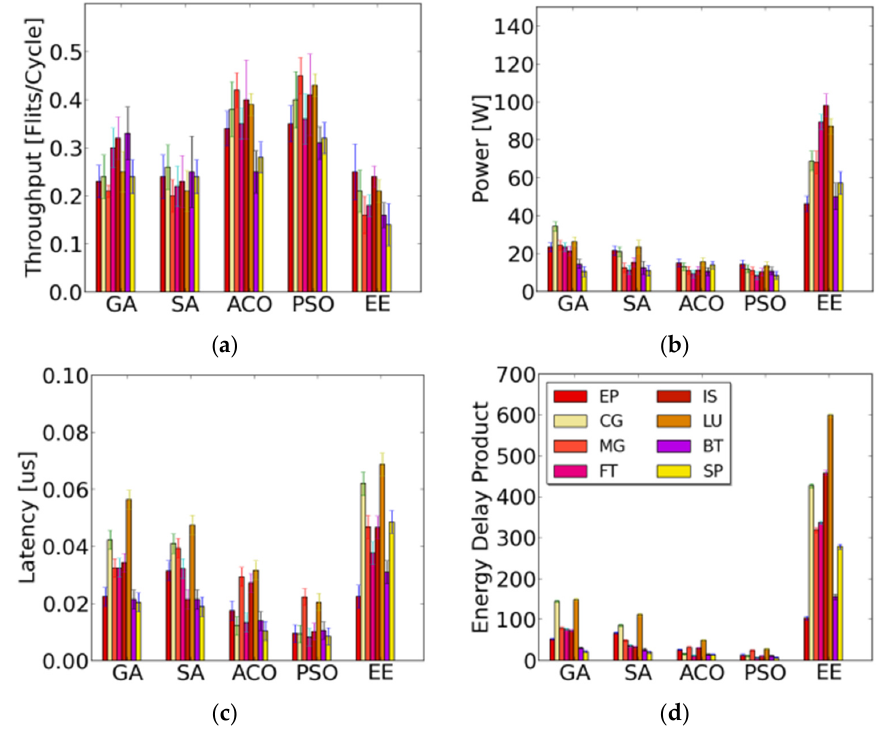
Figure 13. NAS [46] benchmarks comparison for 6 × 6 NoC. ( a ) throughput, ( b ) power, ( c ) latency, and ( d ) energy delay product.